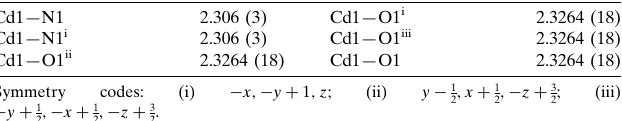
Selected geometric parameters (A˚ , (cid:3)